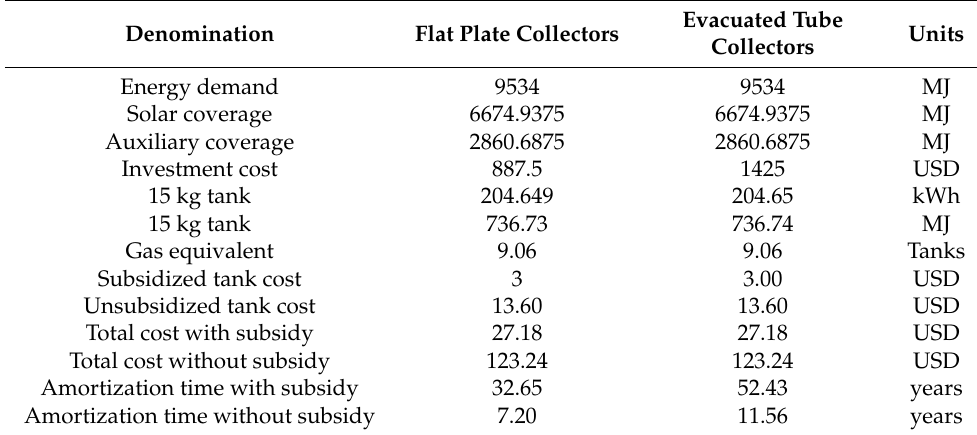
Table 28. Amortization of solar thermal systems in